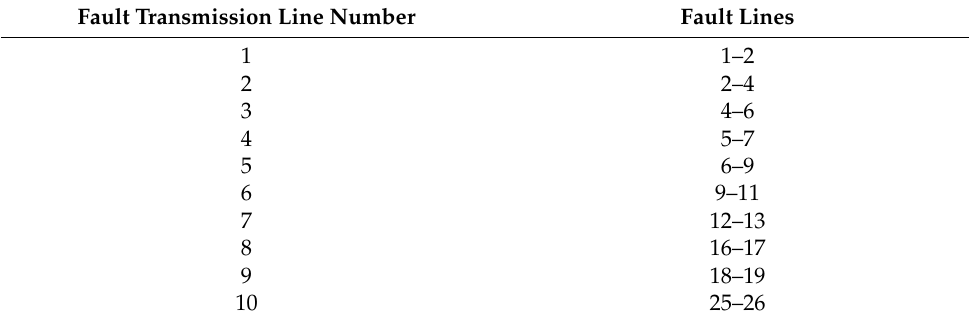
Table 2. Contingency set of IEEE 39 bus